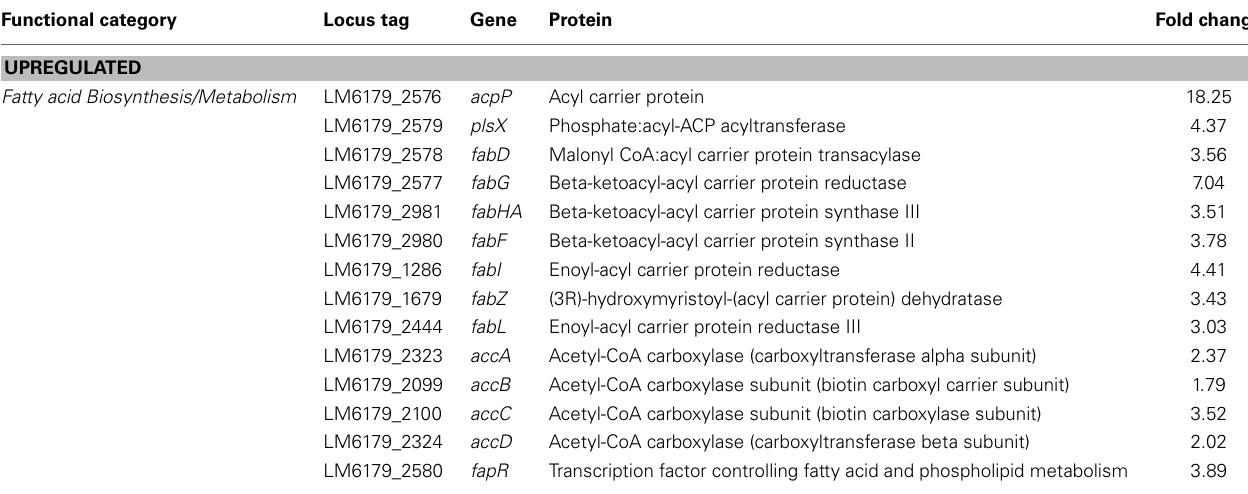
Table 3 | Fatty acid biosynthesis/metabolism genes which change in regulation following exposure of strain 6179 to BZT. Functional